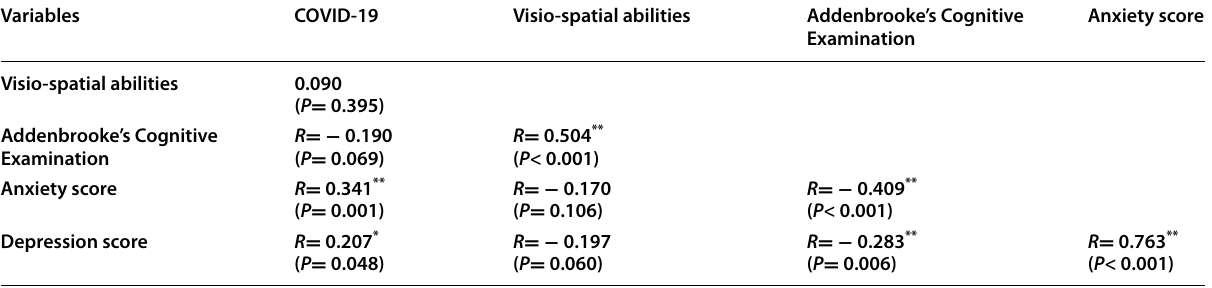
Table 5 Correlations between post‑COVID‑19, visio‑spatial abilities, Addenbrooke’s cognitive examination, anxiety, and depression